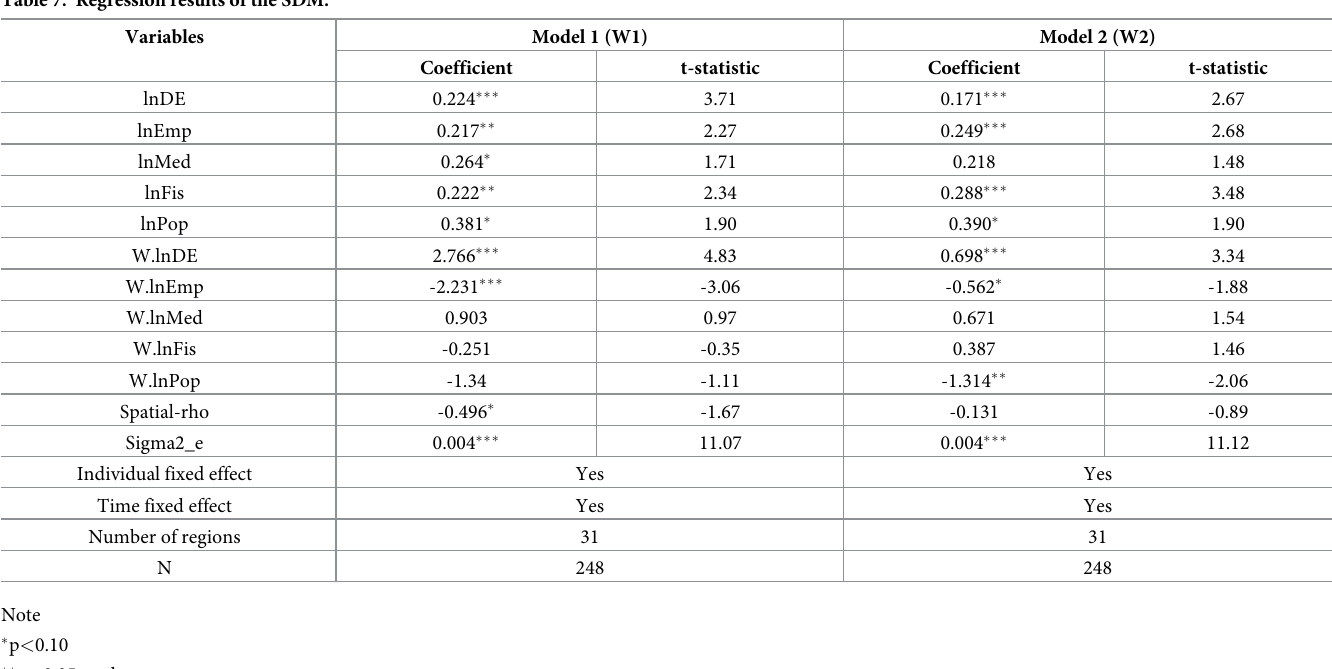
Table 7. Regression results of the